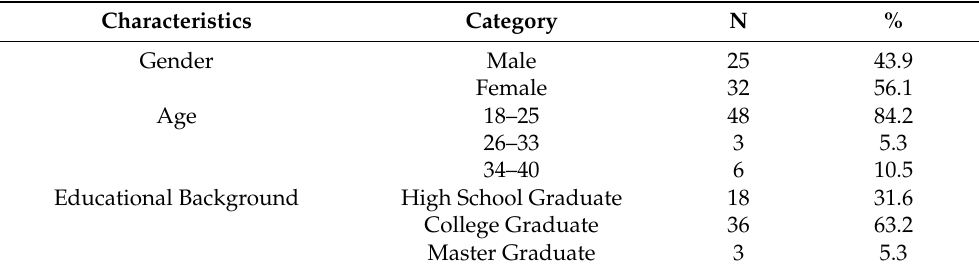
Table 1. The demographic of the participants (N = 57).